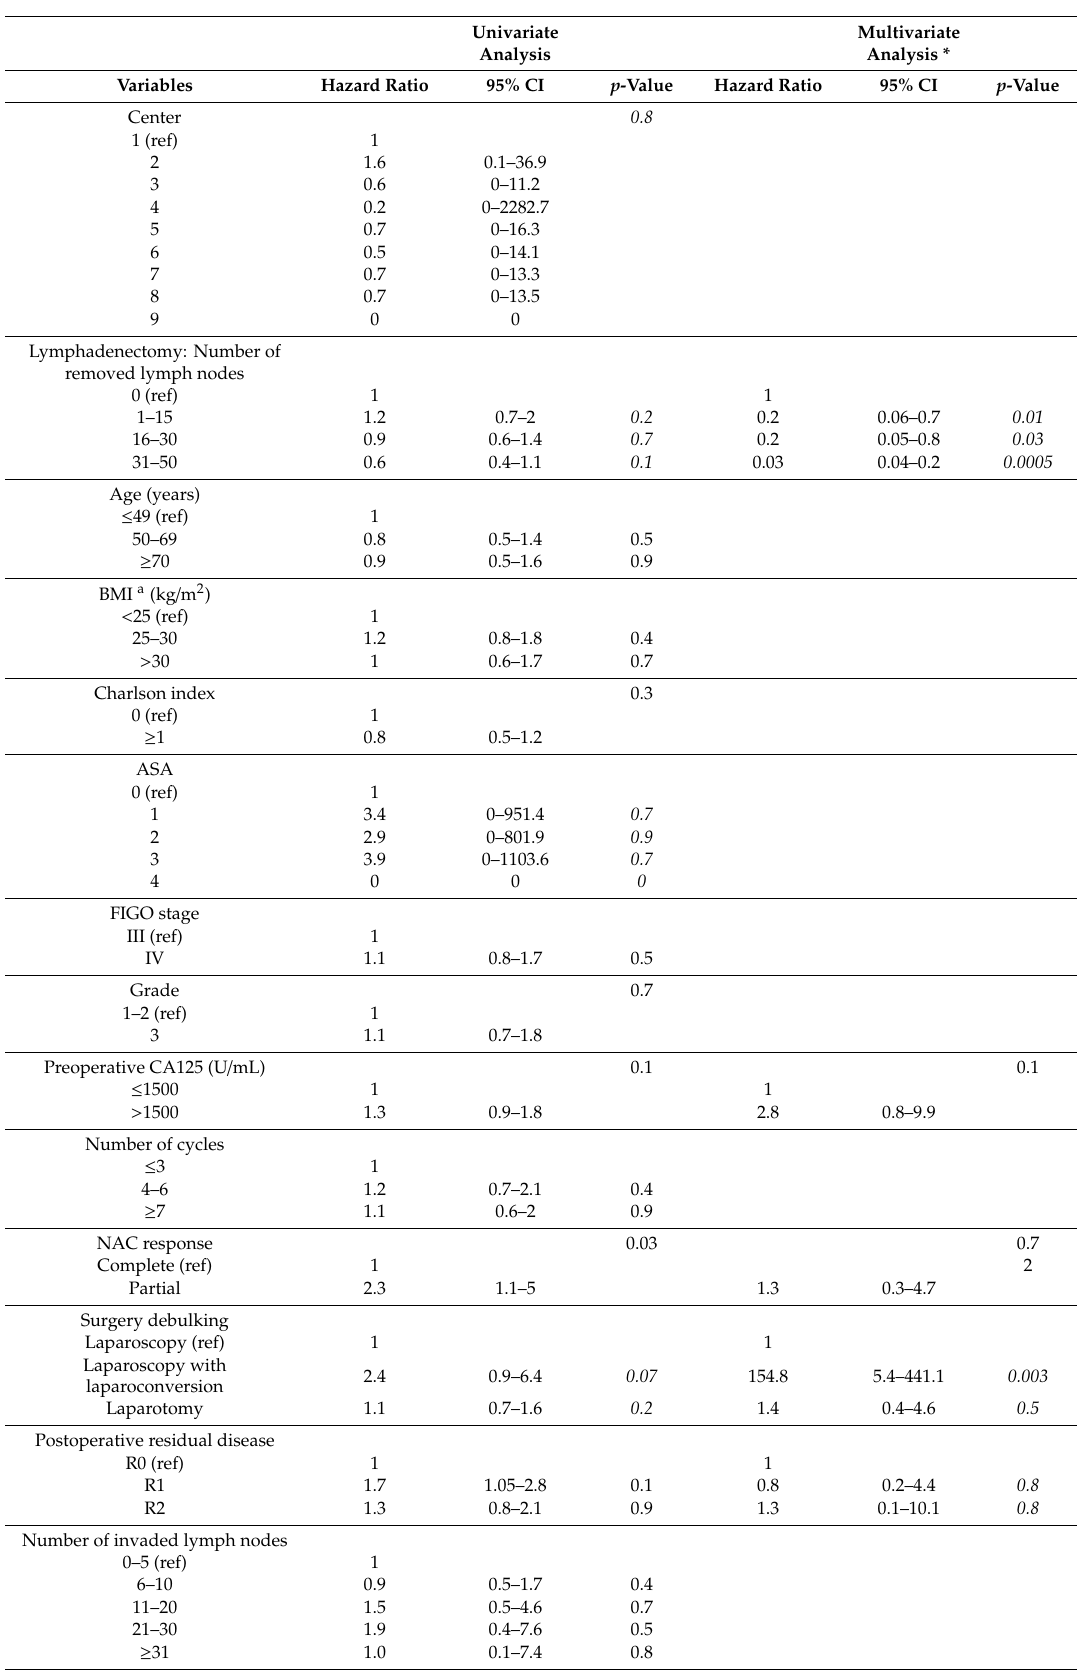
Table 5. Cox regression analysis for progression-free survival